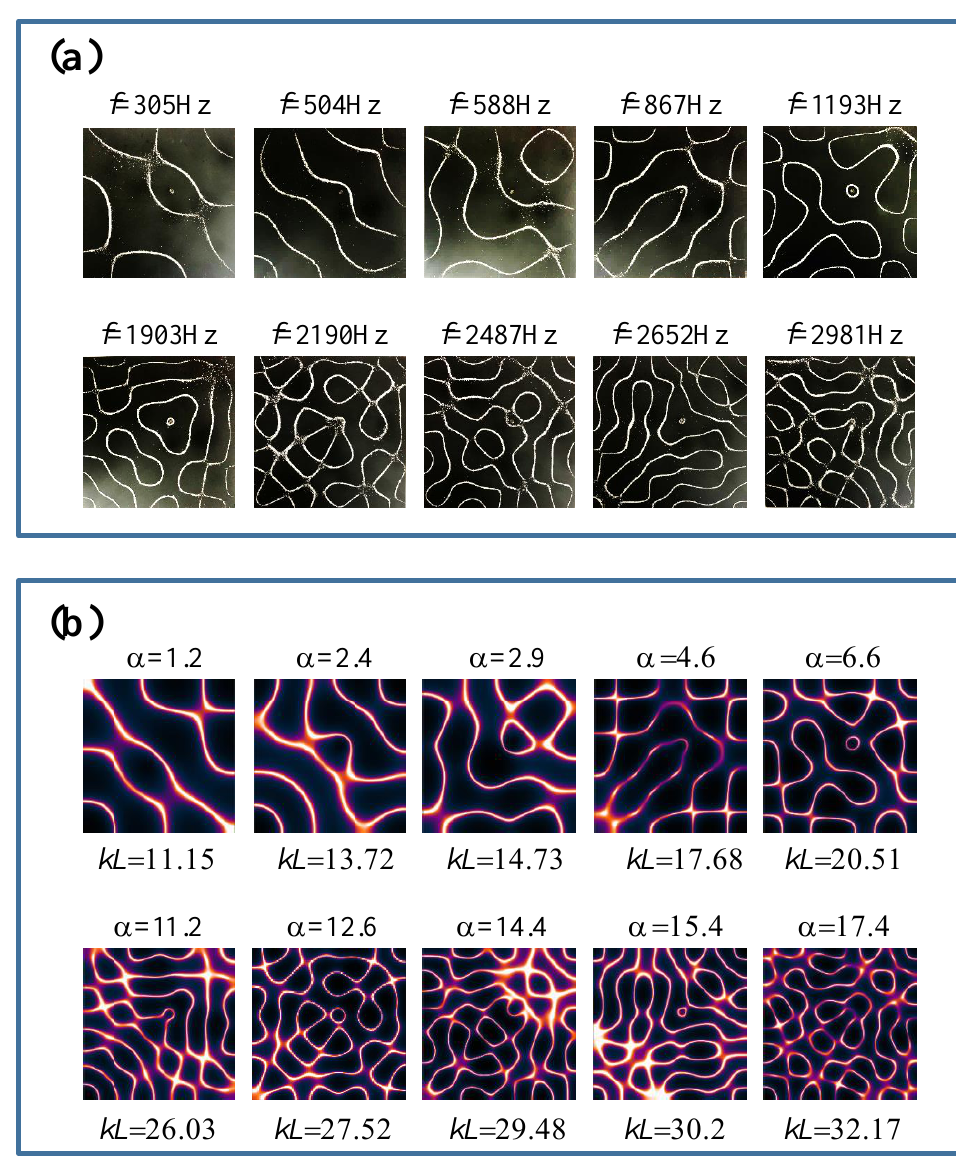
L L  r (off the cen- s